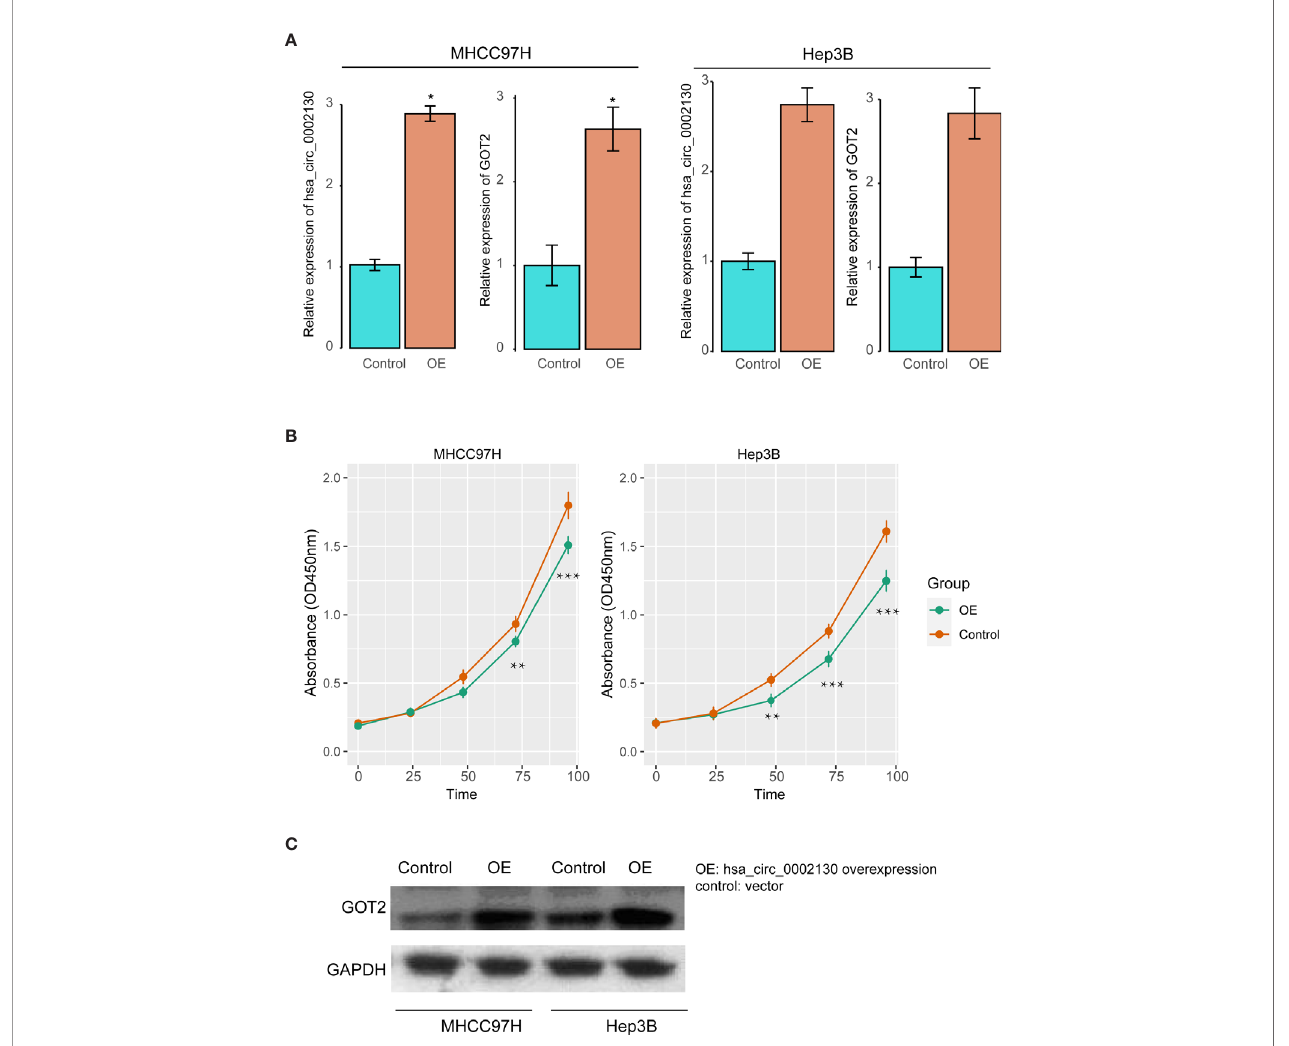
FIGURE 6 | The impact of hsa_circ_0002130 on tumor growth and GOT2 expression. (A) The RNA expression levels of hsa_circ_0002130 and GOT2 in the cell lines with (OE) and without (control) hsa_circ_0002130 overexpression. (B) The CCK-8 assay of the cell lines with (OE) and without (control) hsa_circ_0002130 overexpression. (C) The protein expression of GOT2 in OE and control groups. "*", "**", and "***" indicate the P-value lower than 0.05, 0.01, and 0.001,